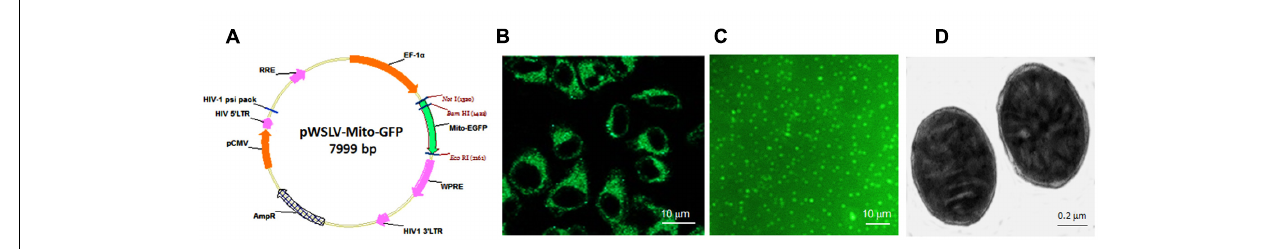
FIGURE 1 | Lentiviral vector transfection and isolated mitochondria. (A) Lentiviral vector plasmid pWSLV/Mito-GFP. (B) The vector was expressed in the cytosol of HepG2 cells. (C) The isolated mitochondria showed green fluorescence. (D) Mitochondrial structure under